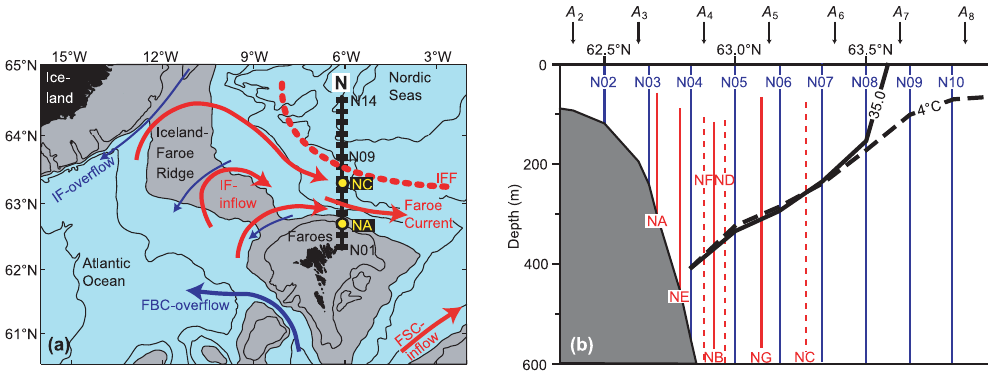
Figure 1. (a) The region between Iceland and the Scottish shelf with gray areas shallower than 500m. The two main Atlantic inflow branches are indicated by red arrows. The Iceland–Faroe inflow (IF inflow) crosses the IFR, meets colder waters, termed Arctic water, in the Iceland- Faroe Front (IFF), and flows north of Faroes in the Faroe Current. The other main inflow branch (the FSC inflow) is also shown. The black line extending northwards from the Faroe shelf is section N with CTD standard stations N01 to N14 indicated by black rectangles. Yellow circles indicate the innermost (NA) and the outermost (NC) ADCP mooring sites on the section. Blue arrows indicate deep overflow into the Atlantic. (b) The southernmost part of section N with bottom topography (gray). Standard CTD stations are indicated by blue lines labeled N02 to N10. ADCP profiles are marked by red lines that indicate the typical range with continuous lines indicating the long-term sites. Altimetry grid points A 2 to A 8 are marked by black arrows and the thick black lines indicate the average depth of the 4 ◦ C isotherm (dashed) and the 35.0 isohaline (continuous) on the